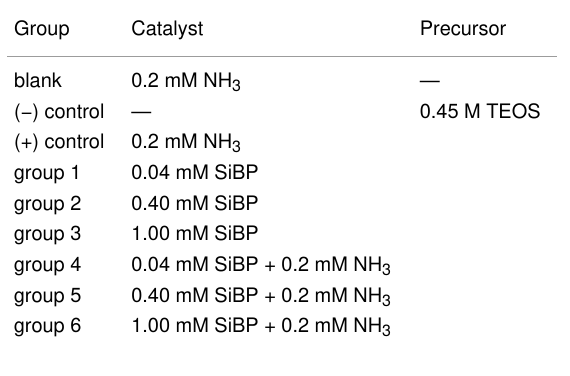
Table 2: Reaction contents for the different conditions studied.